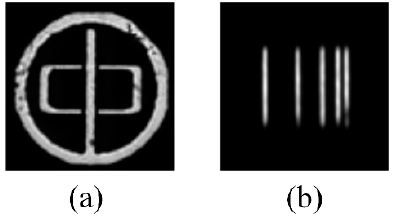
Figure 3. The reconstructed objects: ( a ) imaging object “Zhong” (80 × 80 pixels), ( b ) imaging object “Slits” (80 × 80 pixels, slit width a = 30 µ m, slit height h = 300 µ m, and center-to-center separation d = 60, 120, 180, and 240 µ m).